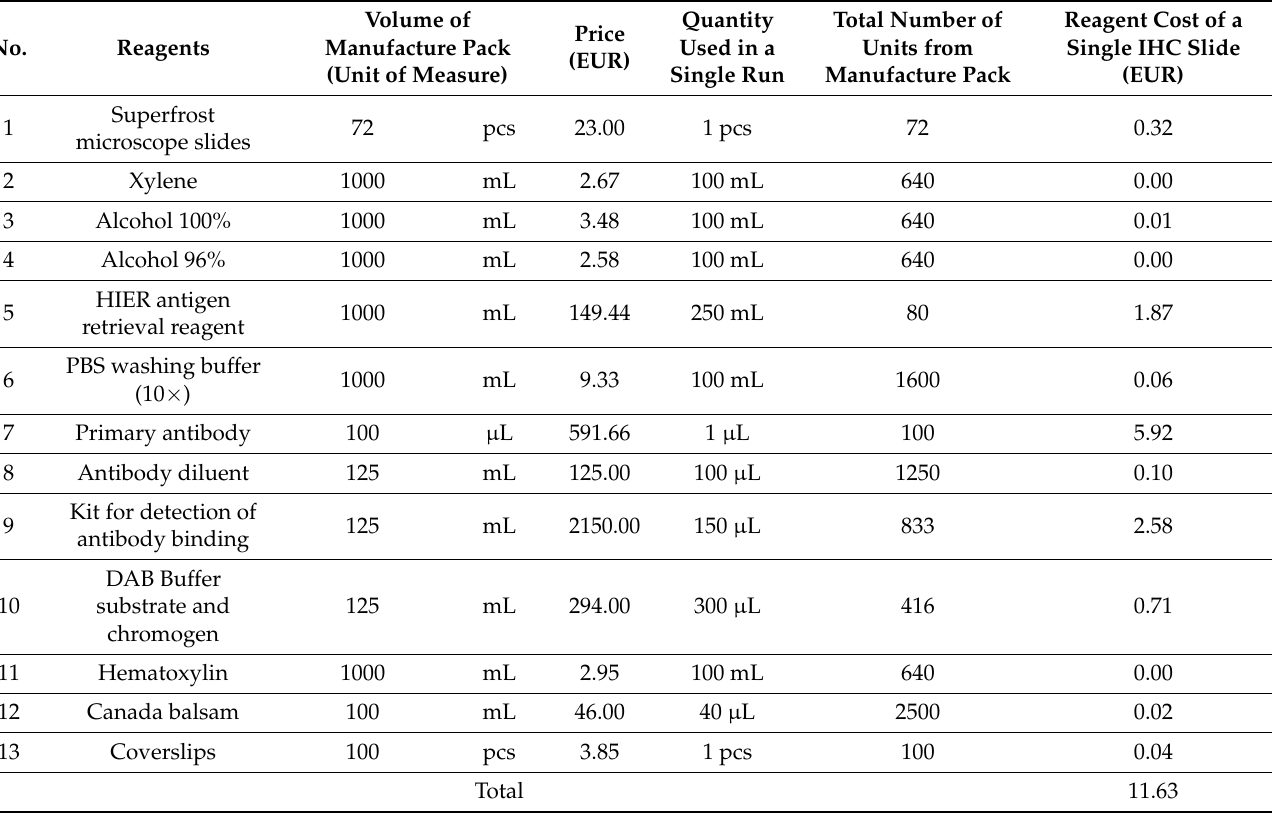
Table 2. Costs of reagents used for single immunohistochemistry run (one IHC microscope slide) in manual procedure.